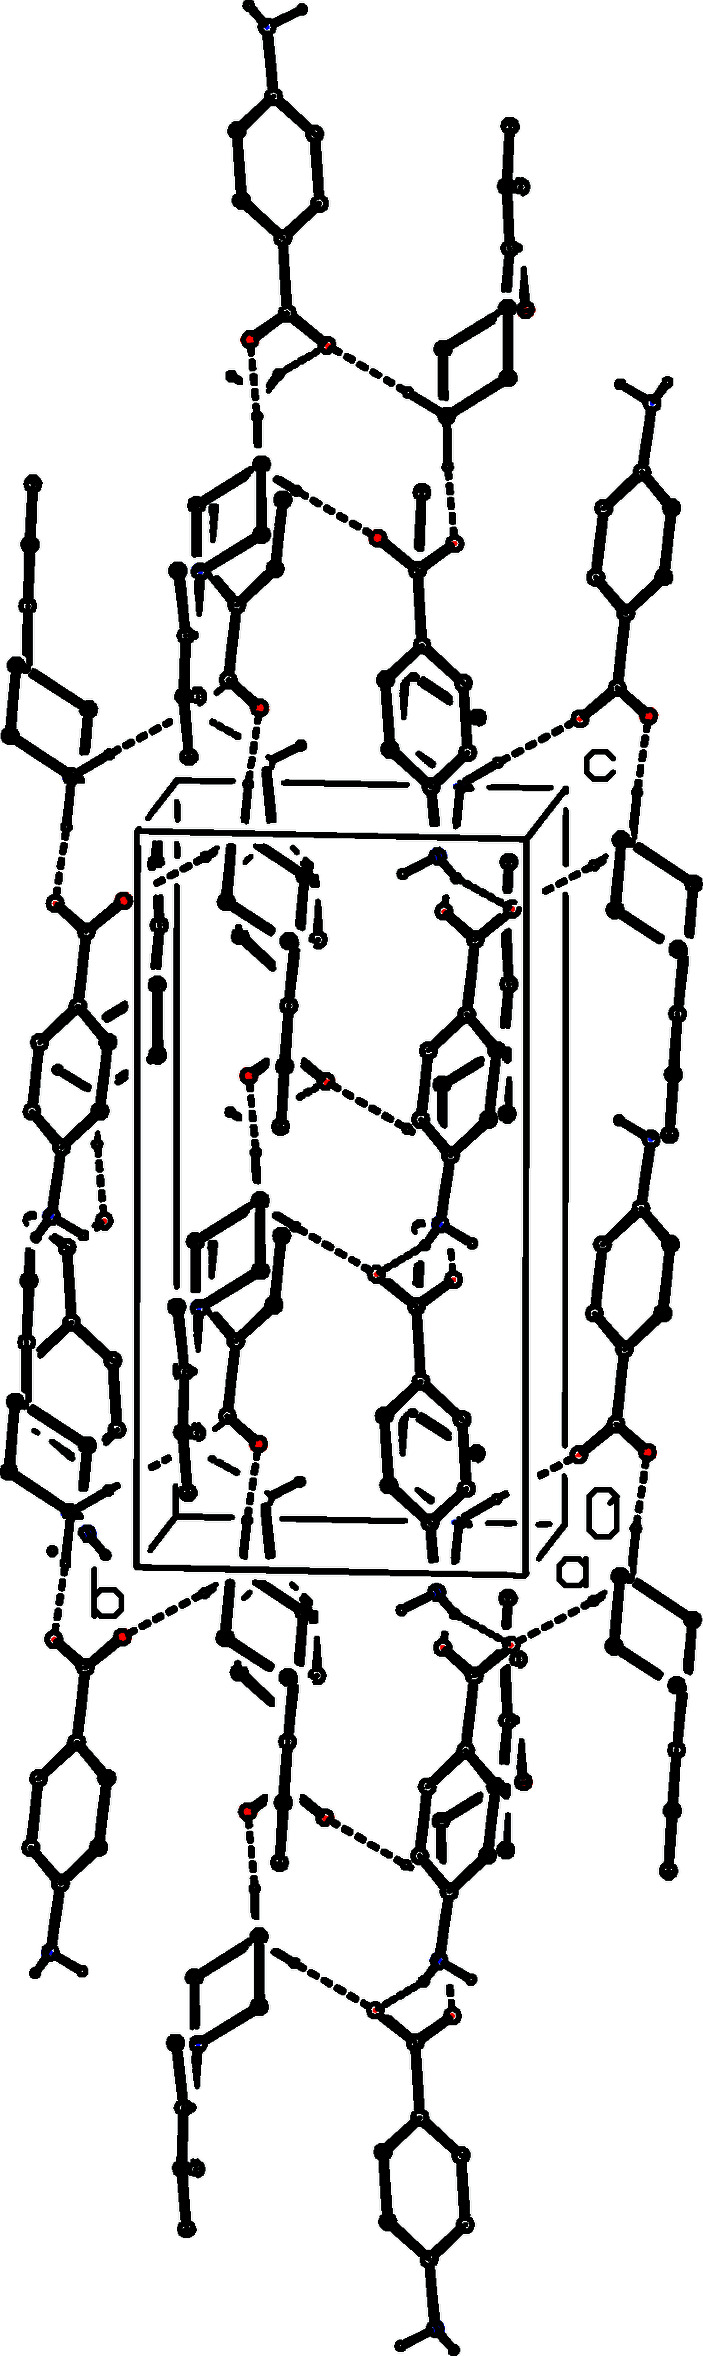
Part of the crystal structure of compound (IX) showing the formation of a hydrogen-bonded sheet lying parallel to (100). Hydrogen bonds are drawn as dashed lines and, for the sake of clarity, the H atoms bonded to C atoms have been omitted.